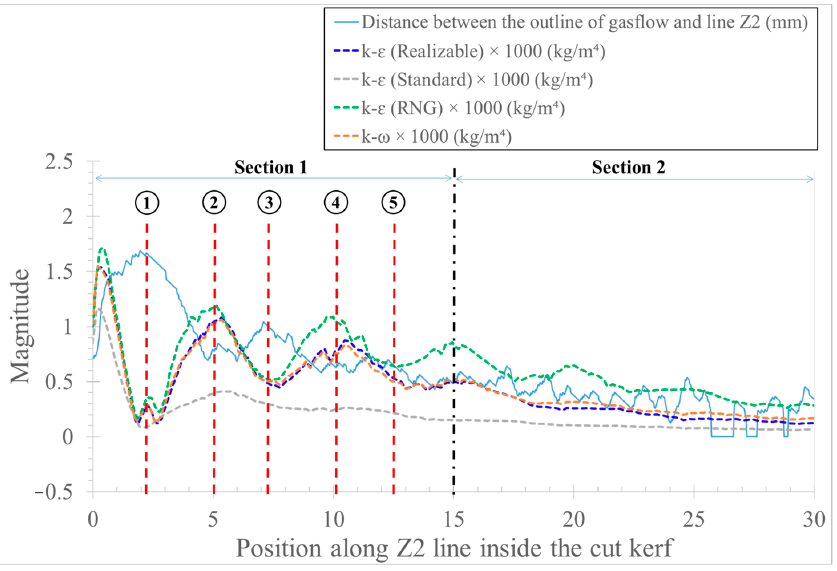
Figure 17. Comparison between density gradient fluctuation predicted by numerical simulation with different turbulent models and experimental results.